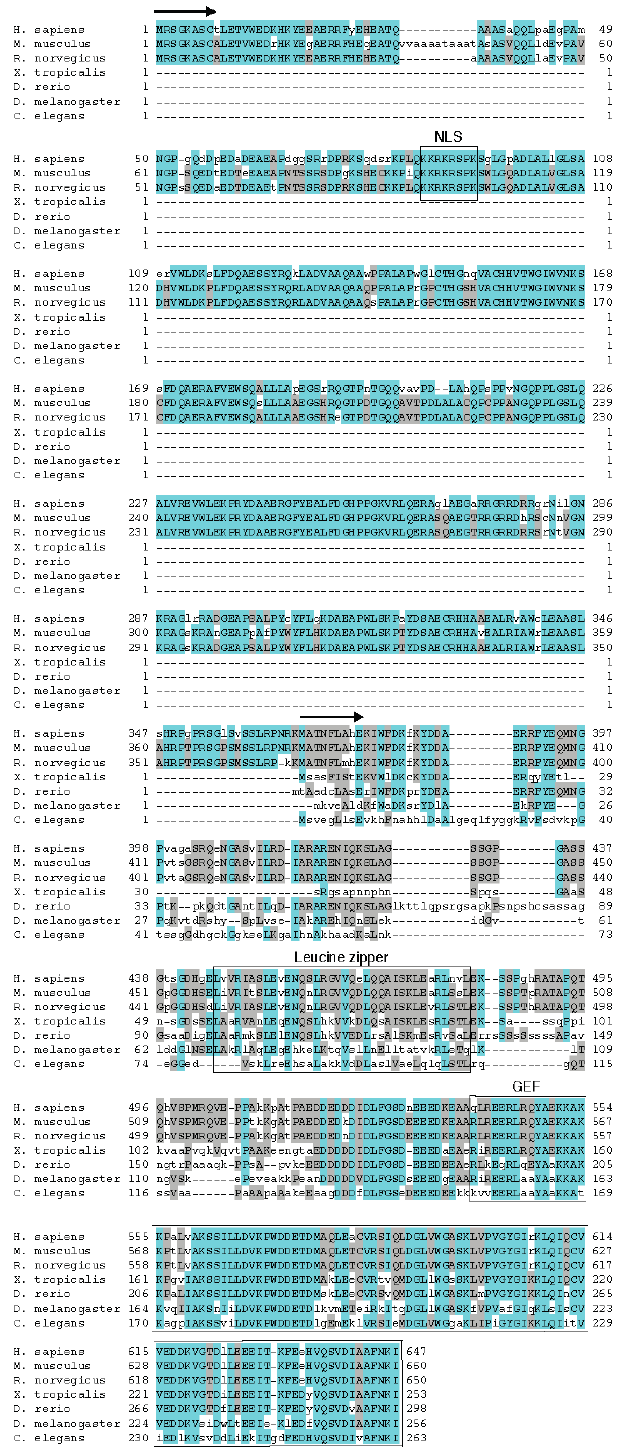
Figure 3. Alignment of the amino acid sequences of mammalian eEF1B δ L and other eukaryotic eEF1B δ proteins. Within the compared sequences, the blue highlights show primary conserved regions, and the gray highlights show secondary conserved regions. Arrows indicate each N -terminus of the mammalian eEF1B δ L and other eukaryotic eEF1B δ proteins. The nuclear localization signal (NLS), leucine-zipper motif and guanine nucleotide exchange factor (GEF) domain are marked by boxes and text. MUSCLE was used to create the alignment